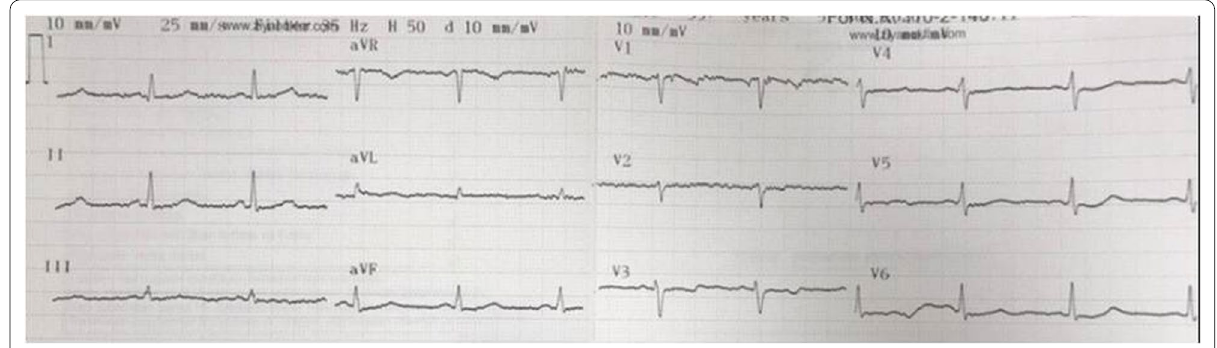
Fig. 3 Postoperative control electrocardiography